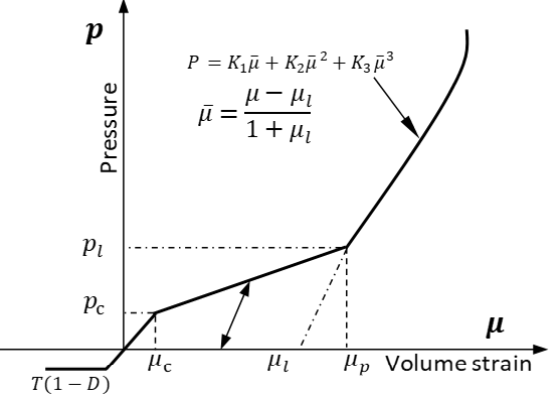
Figure 7. EOS curve of the HJC model in various stress stages.